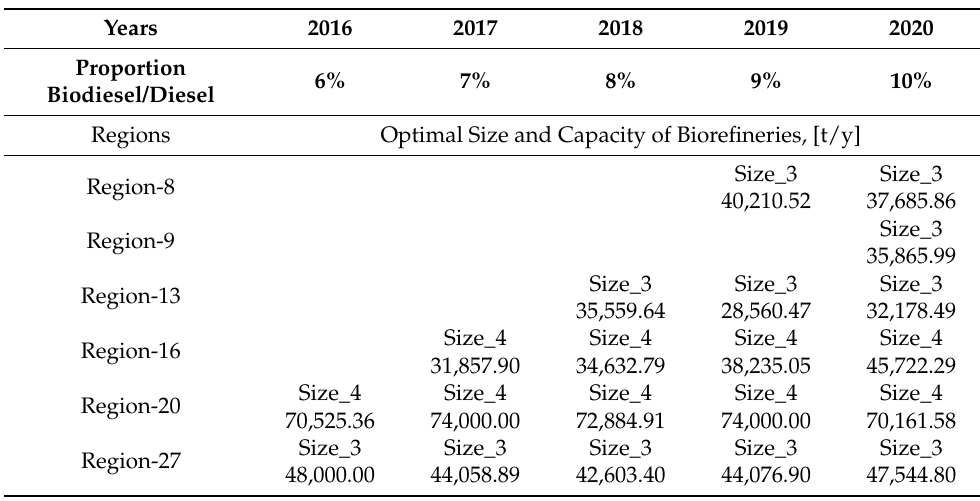
Table 10. Optimal size, capacity and location of biorefineries and facilities for solid waste use using criterion: (B) Minimum total annual